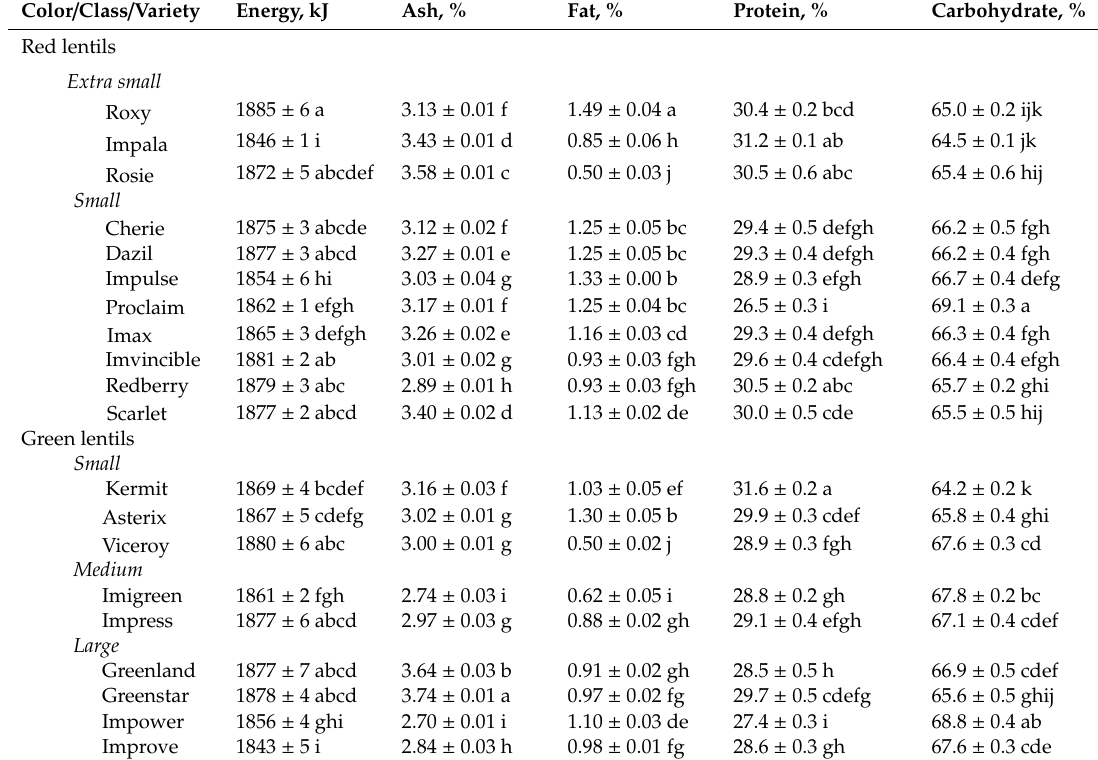
Table 1. Proximate analysis of freeze-dried cooked lentil powders (dry weight